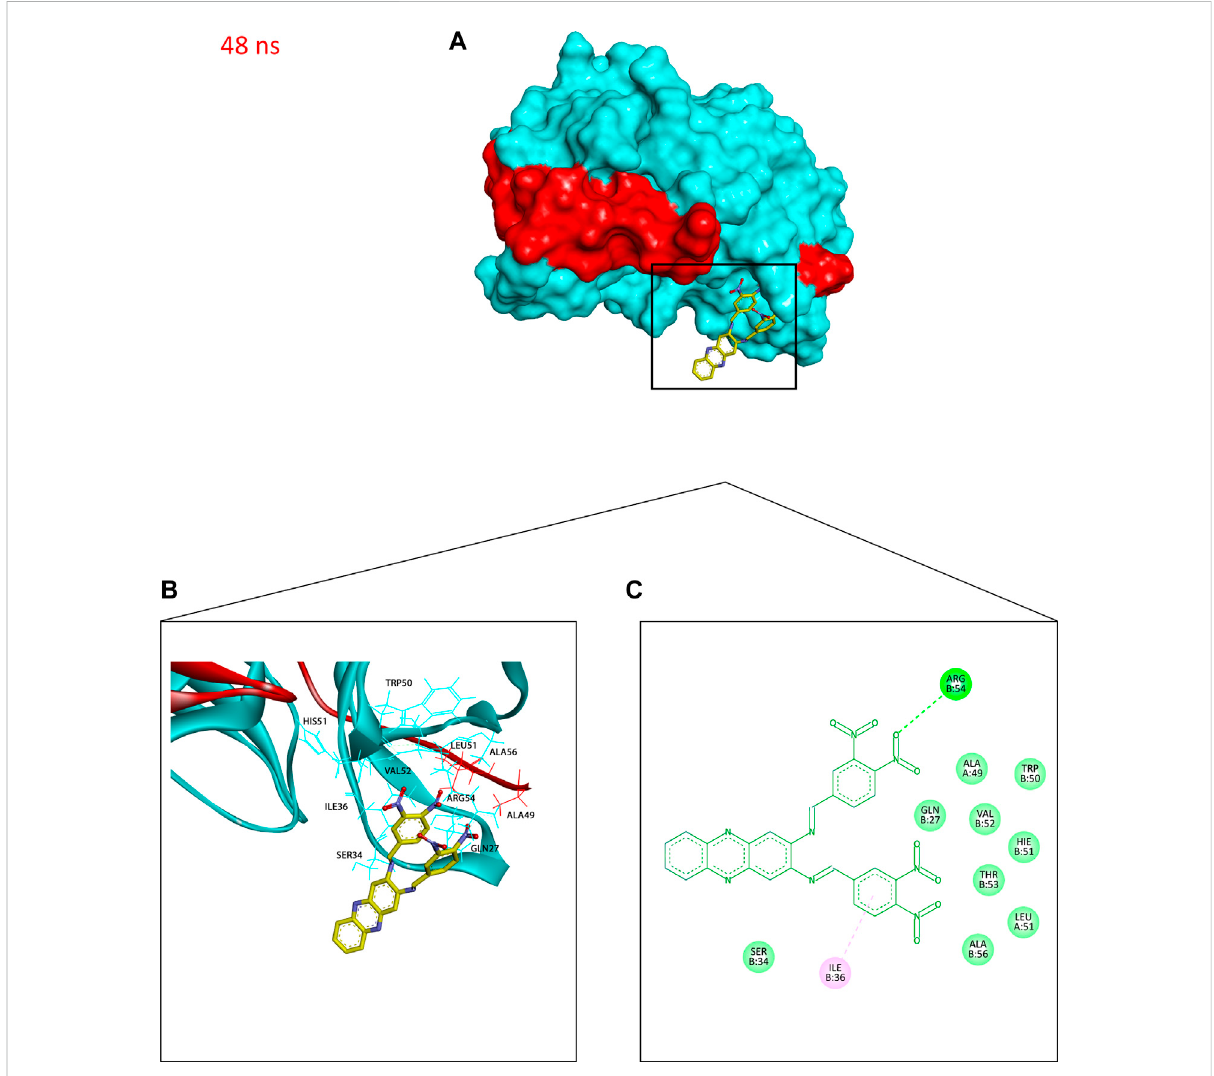
FIGURE 10 Binding conformation of compound 4 (stick representation with yellow carbons) at the catalytic binding site of DENV2 NS2B-NS3 protease (cyan for the NS3pro chain and red for the NS2B chain) at 48 ns showing the phenazine ring system protruding out of the protease binding pocket which caused the slight elevation in its RadGyr reading. (A) Surface presentation of the protease. (B) 3D representation of the interacting amino acid residues. (C) 2Drepresentationoftheinteractingaminoacidresidues.TheframewasextractedusingUCSFChimera1.15andrepresentedusing BIOVIA Discovery